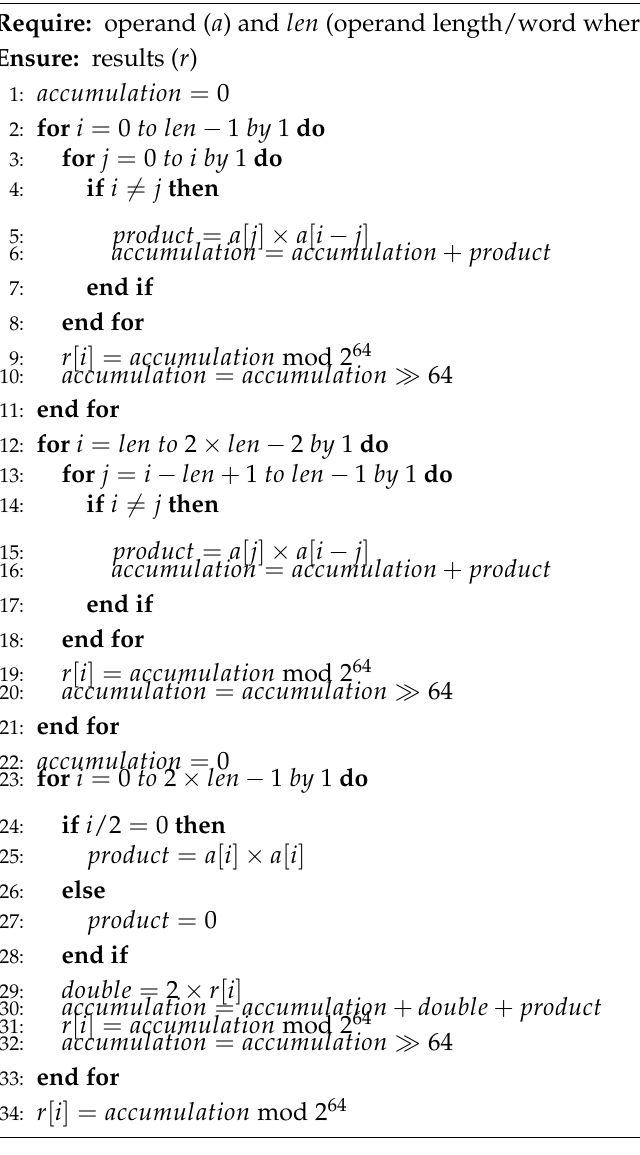
Algorithm 4 64-bit wise scalable product-scanning for